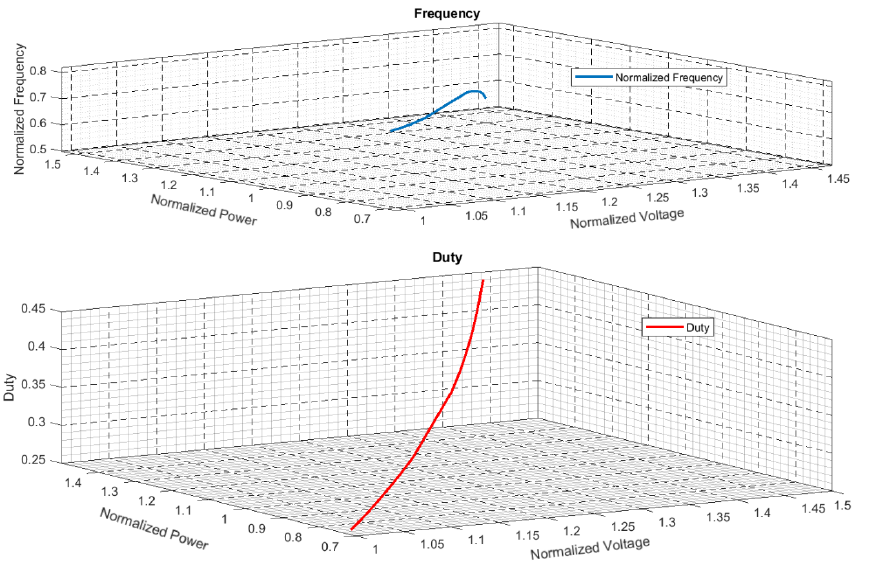
Figure 17. Illustration of normalized frequency and duty at a fixed load of ˆ Ω = 1.387, corresponding to 10 Ω .